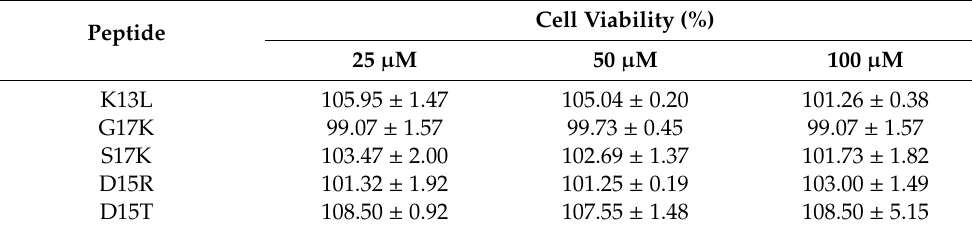
Table 4. In vitro cytotoxic activity of the investigated peptides against LLC-MK2 cells.